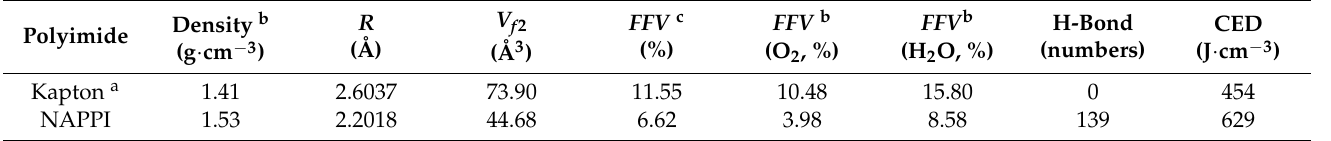
Table 4. Simulated fractional free volume ( FFV ) and H-bonds numbers of polyimide films. Density Polyimide